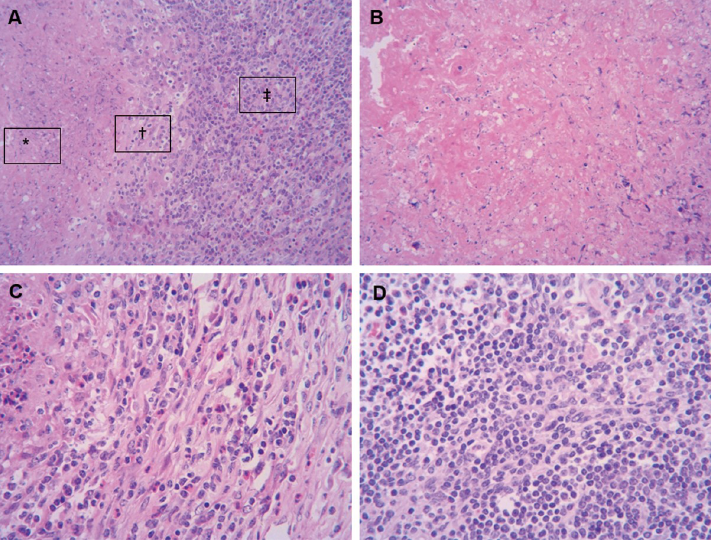
Fig 3. H&E staining of sections of hilar lymph nodes. (A) Typical tuberculous granulomas consisted of three parts, as shown at the box: the center of the granuloma displays evident necrosis and mineralization ( � ); numerous epithelioid cells and Langhans’ giant cells are present in the intermediate layer of the granuloma (†); A large number of lymphocytes are present in the external layer of the granuloma (‡). Magnification × 200. Box ( � ), Box (†), and Box (‡) indicate areas enlarged in panel B, C, and D, respectively. (B) Amorphous pink caseous material composed of the necrotic elements of the granuloma as well as the infectious organisms. Magnification × 400. (C) Epithelioid cells aggregation and Langhans’ giant cells could be seen subsequently. Magnification × 400. (D) Redundant lymphocytes infiltrated. Magnification × 400.